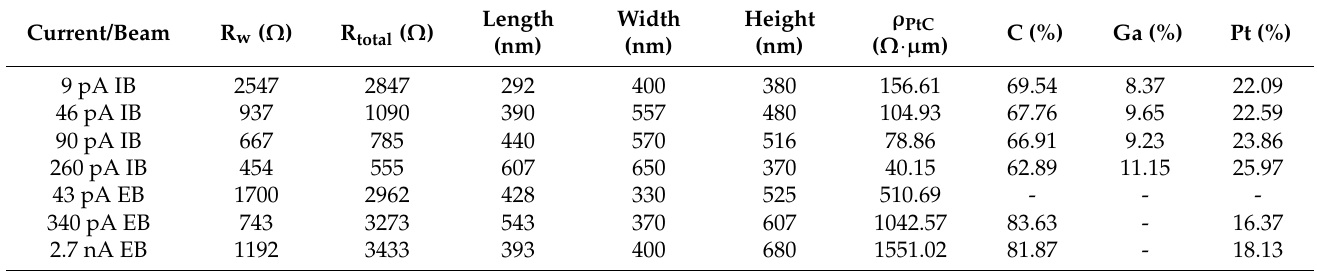
Table 1. Geometrical data and resistance measurements. From these measured values for the geometry of the nanowires, the total resistance, the resistance of the wiring, and the resistivity of the PtC can be calculated. Furthermore, the atomic amount of C, Ga, and Pt based on the EDX analysis (nanotips) is shown.